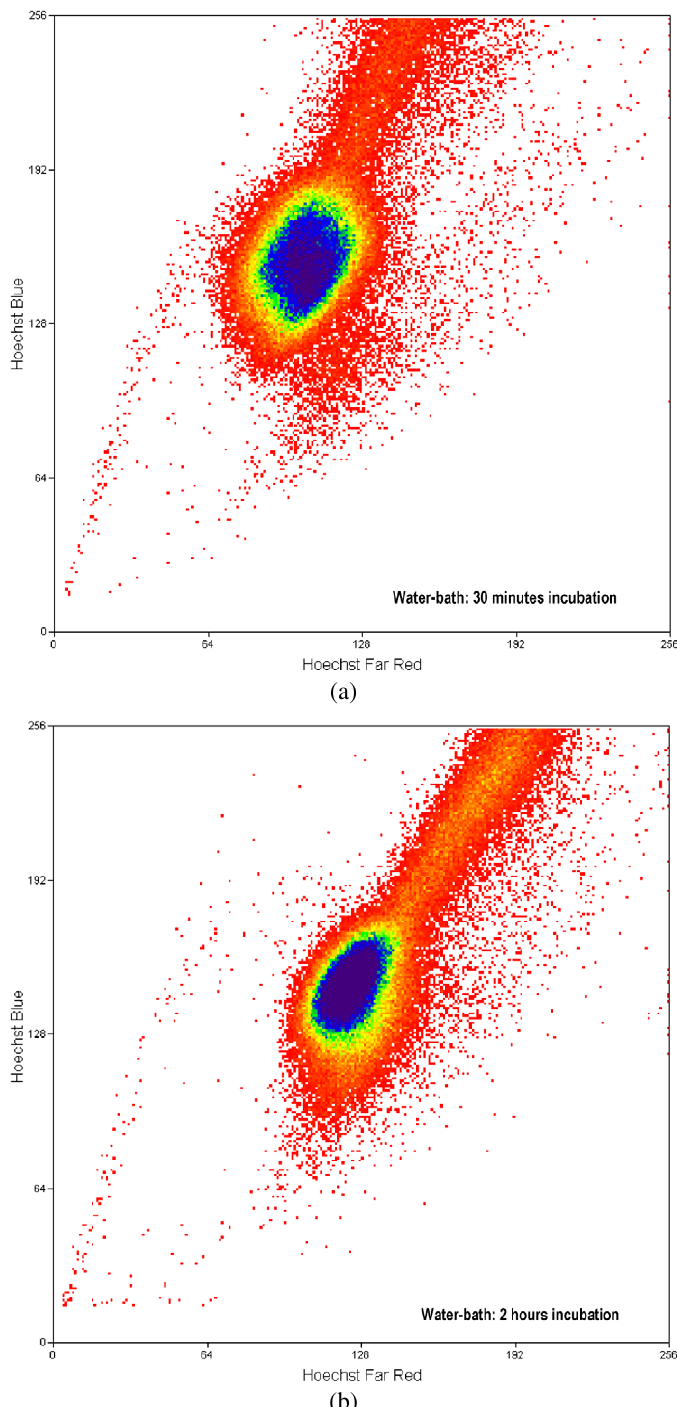
Fig. 6. Ho342 staining of a human bone marrow sample using a water-bath and its comparison with a CO 2 cell-incubator. A more accurate staining was observed when a water-bath was used (a) and (b). The influx of Ho342 is slower using a cell-incubator (c) and (d), giving an inappropriate SP profile leading to an overestimation of the SP